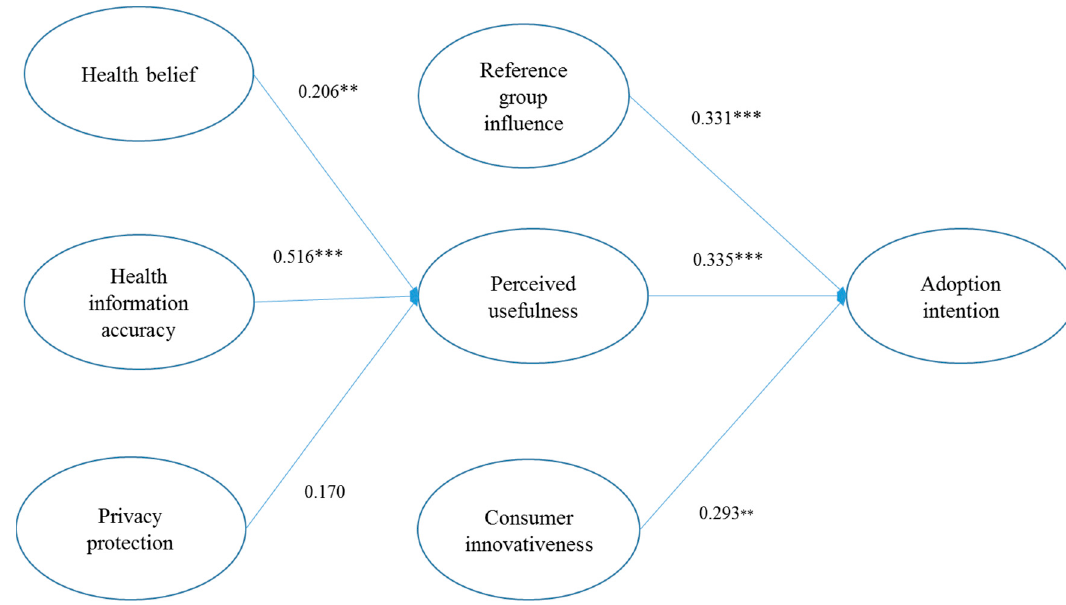
Figure 2. Results of the theoretical model. Paths were considered significant at ** p < 0.01, *** p < 0.001. Table 3. Results of hypotheses testing.